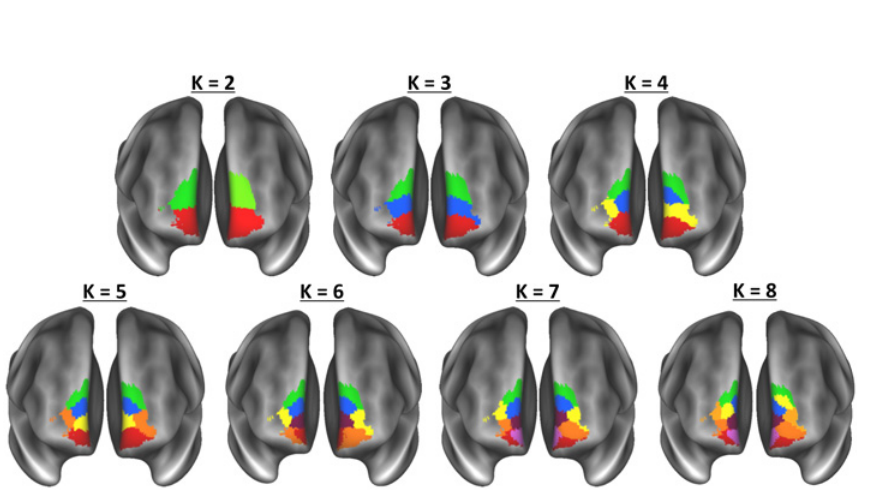
Fig 2. Cluster maps for all clustering solutions for the regions of cytoarchitectonic regions identified by Bludau et al. (2013) as frontal pole. Colors used here correspond to the colors of the labels and/or tracts in the following